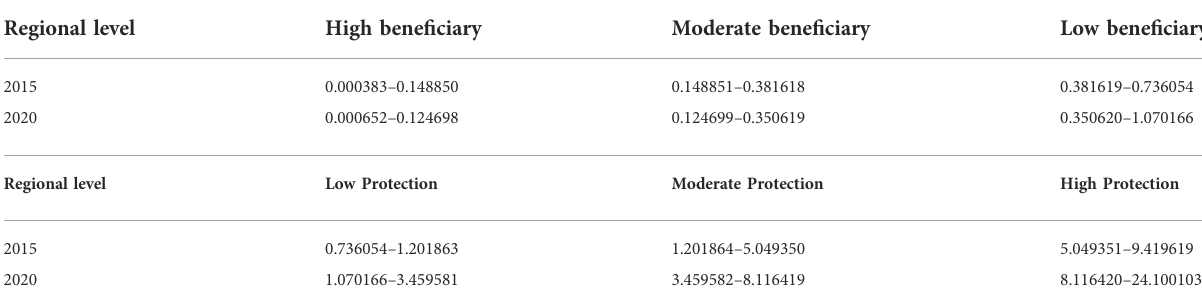
TABLE 1 Eco-compensation priority sequence